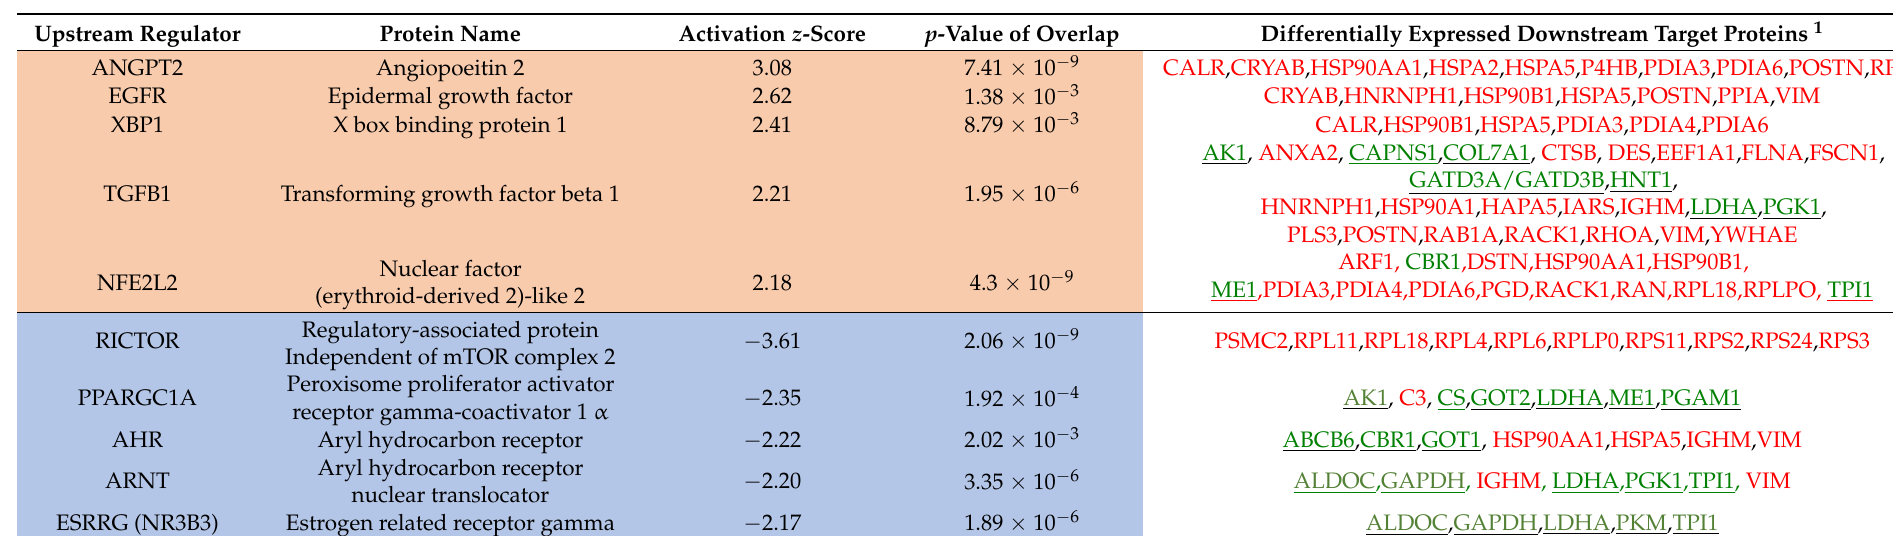
Table 3. Upstream regulators predicted to be activated (orange) or inhibited (blue) in wooden breast (WB) myopathy compared to normal muscle based on differentially expressed downstream target molecules in commercial